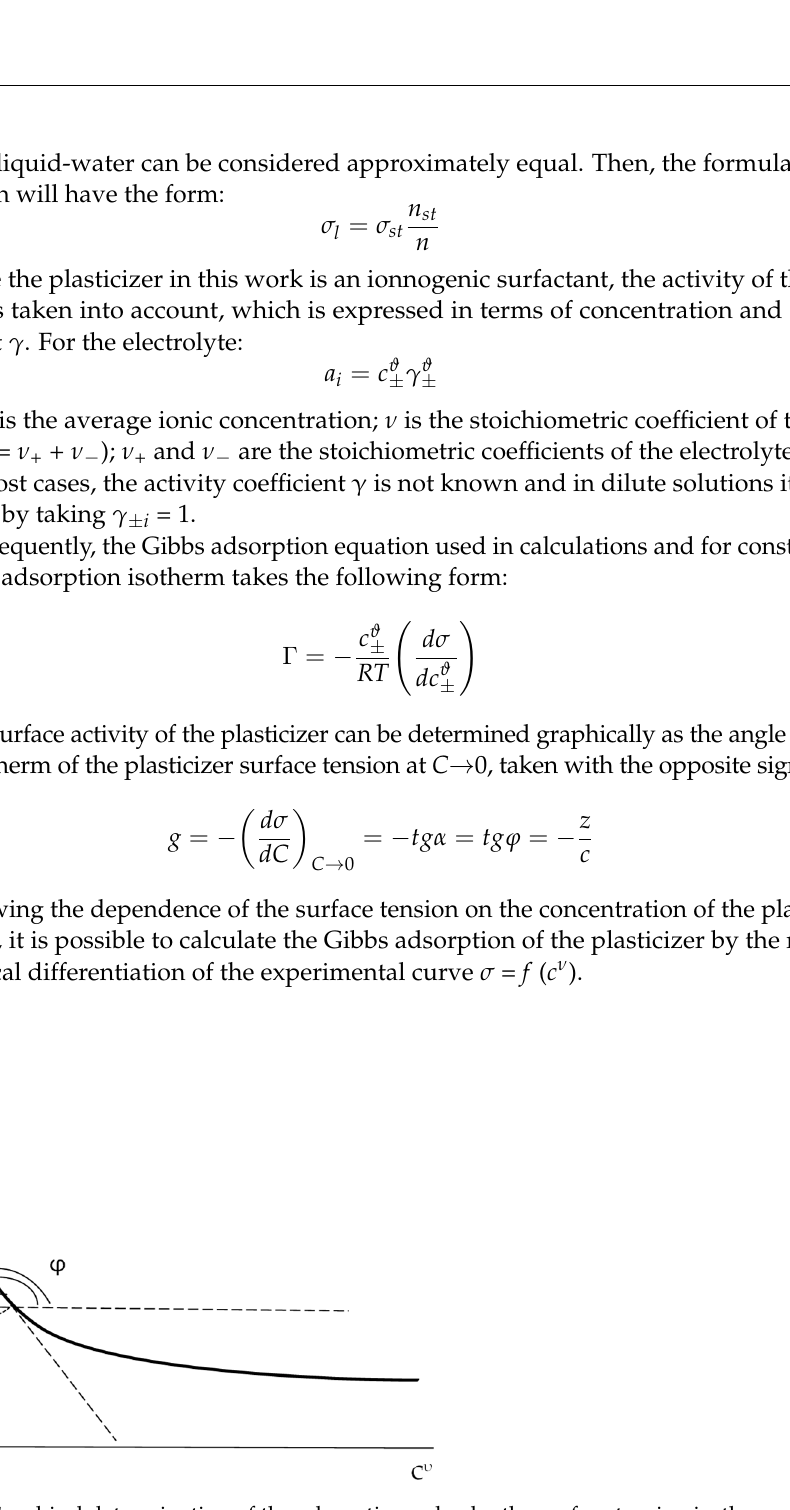
Figure 3. Graphical determination of the adsorption value by the surface tension isotherm. Substitute the obtained value according to Equation (7) into Equation (6):